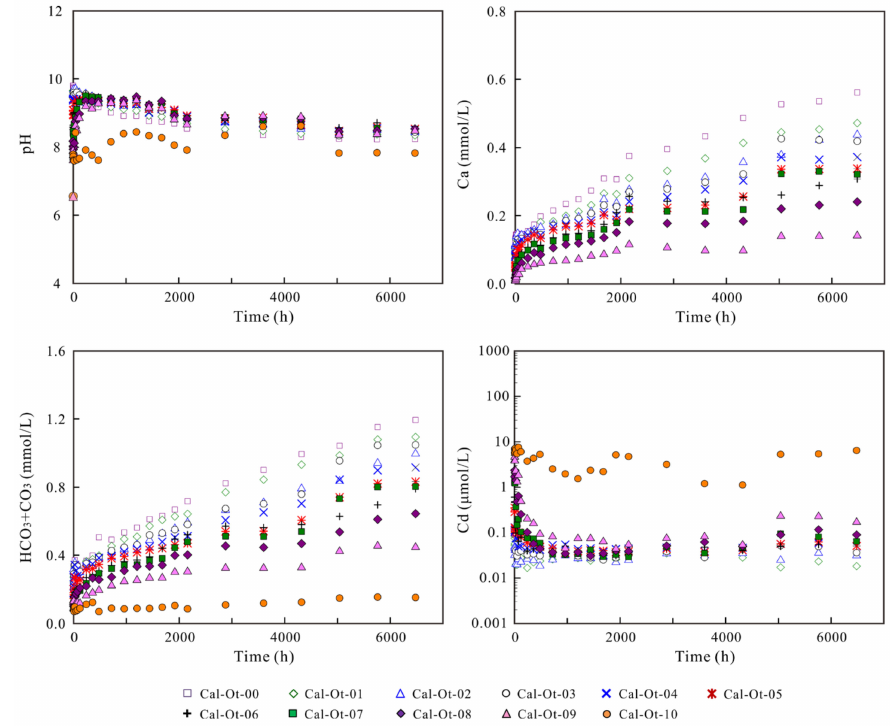
Figure 5. Change of the aqueous pH, the total dissolved calcium, the total dissolved cadmium and the total dissolved H 2 CO 30 during the dissolution of the (Ca 1 − x Cd x )CO 3 solid solutions in the N 2 -degassed